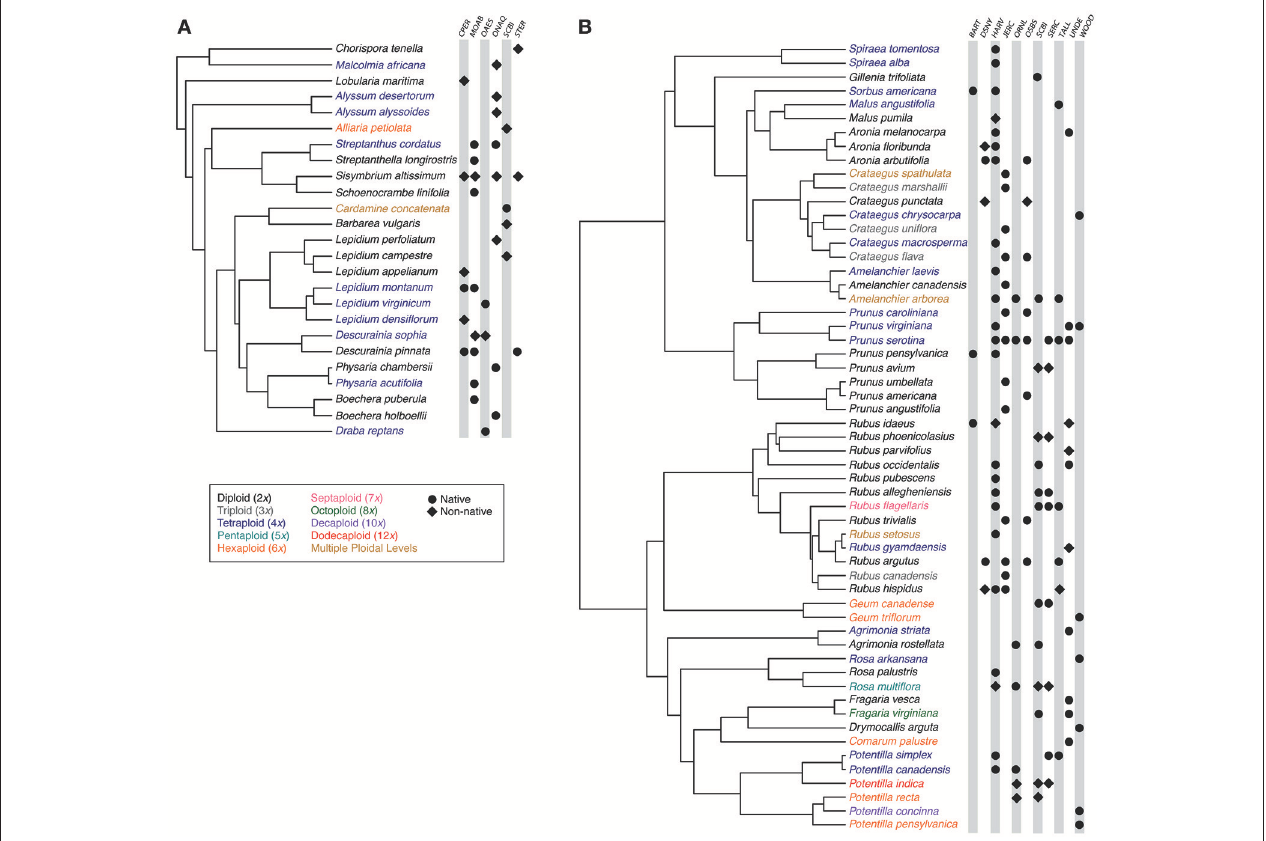
FIGURE 2 | Phylogenetic trees showing (A) Brassicaceae and (B) Rosaceae community members and their occurrence in each study community. Species names are colored to indicate ploidal level. Symbols indicate the species’ presence within a study community, with circles and diamonds indicating whether the species is native or non-native, respectively. Site abbreviations follow Figure 1